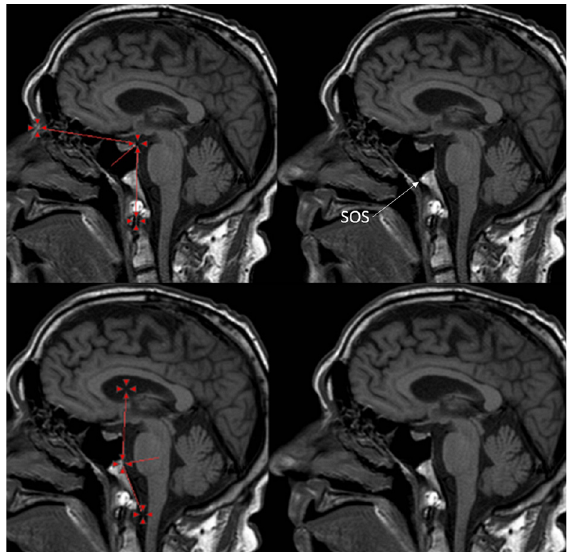
Figure 2. Cranial base angle (Upper left) and Sphenooccipitalis synchondrosis angle (Lower left). In the right side are depicted original image for detailed anatomical visualization.